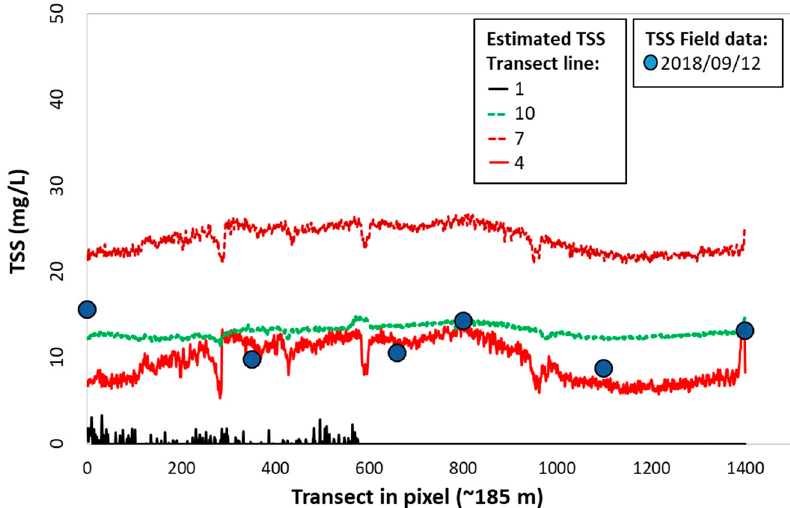
Figure 16. Field and estimated total suspended solids (TSS) concentrations for the 2018/09/12 survey in the Paranoá reservoir, for different models using the near-infrared (NIR), green and red bands of